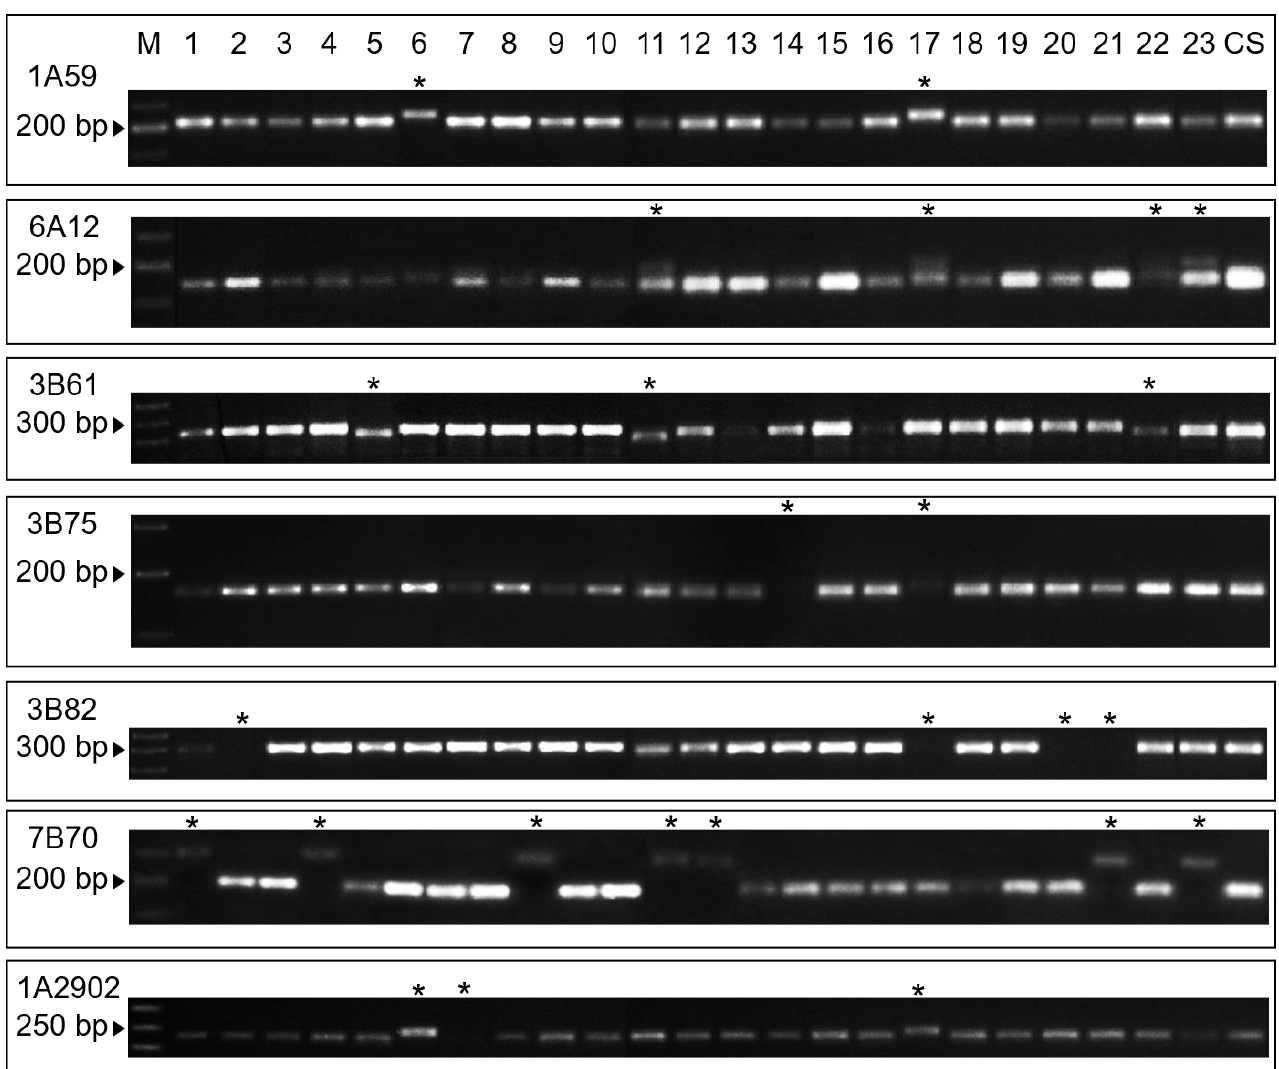
Figure 5. The analysis of lncRNA gene polymorphism in the collection of spring triticale. Individual triticale genotypes were: Dublet (1); legalo (2); Sandro (3); Scallop (4); Lana (5); In memory of Merezhko (6); Ukro (7); Ulyana (8); Khlebodar Ukrainian (9); Yarilo (10); 131/1656 (11); 131/7 (12); 6-35-5 (13); C238 (14); C245 (15); C259 (16); C95 (17); V17/50 (18); L8665 (19); P2-16-20 (20); P 13-5-2 (21); P13-5-13 (22); PRAG 551 (23); Chinese Spring (CS). DNA marker Step50 plus (Biolabmix, Novosibirsk, Russia) (M). Non-reference alleles are indicated by star